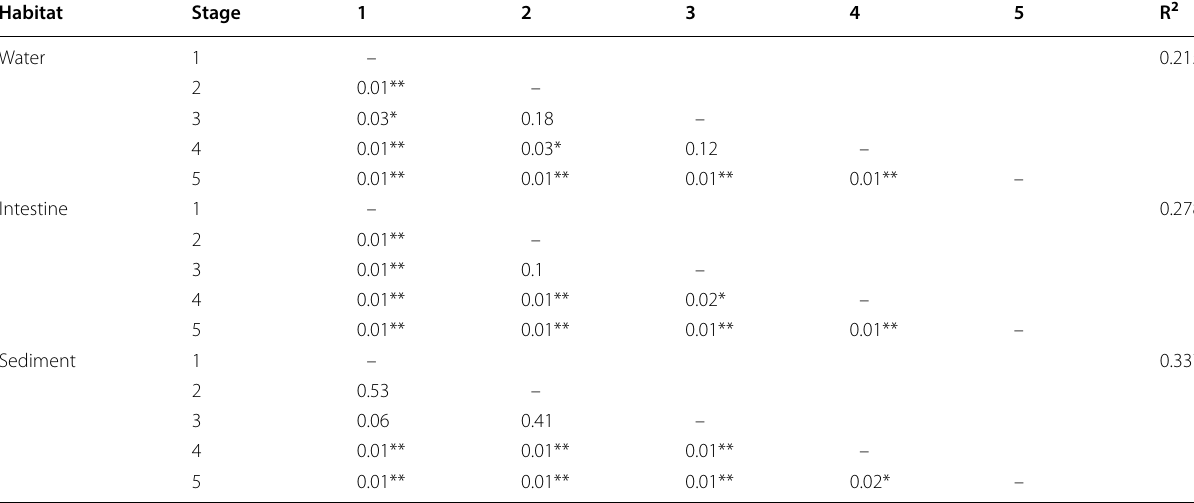
PERMANOVA was used to compare significant differences at different culture stages Significant differences are indicated by asterisks (*, P < 0.05; **, P < 0.01)